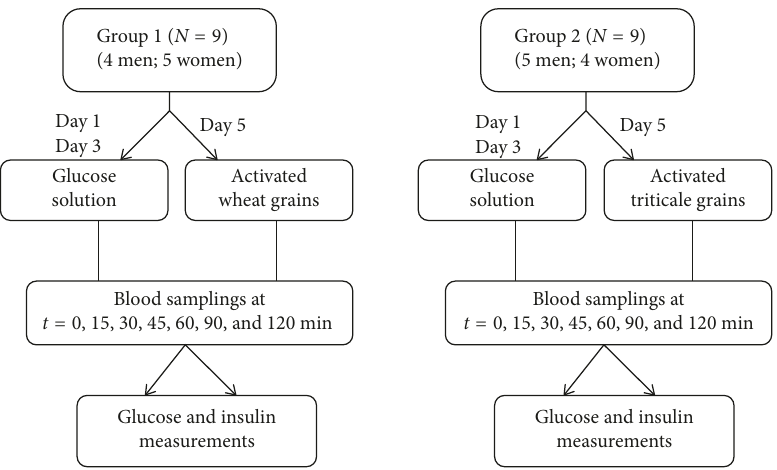
Figure 1: The study